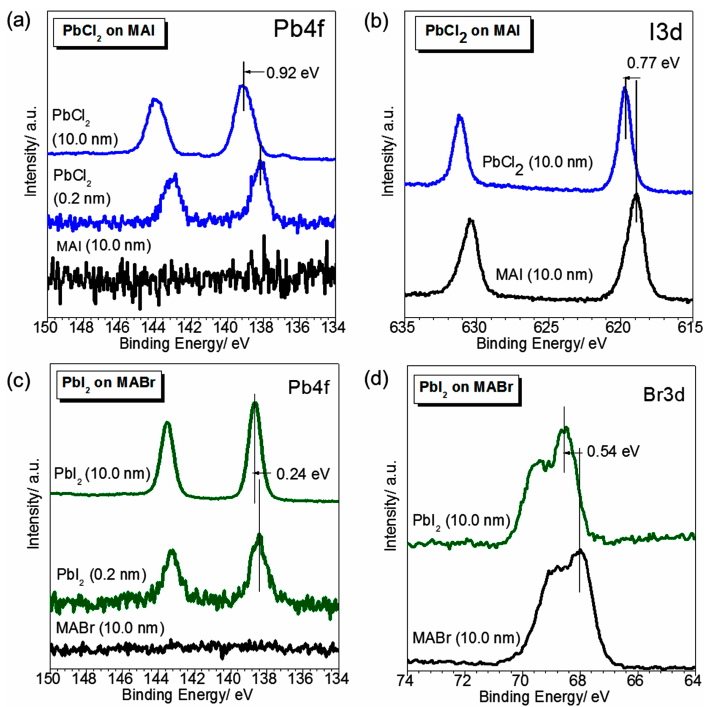
Figure 8. High-resolution XPS core level spectra of ( a ) Pb 4f and ( b ) I 3d when different thicknesses of PbCl 2 are deposited on 10.0 nm of MAI. XPS core level spectra of ( c ) Pb 4f and ( d ) Br 3d when different thicknesses of PbI 2 are deposited on 10.0 nm of MABr [88]. Copyright © 2015, American Chemical Society.